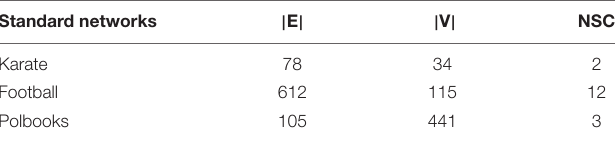
TABLE 1 | Standard networks.